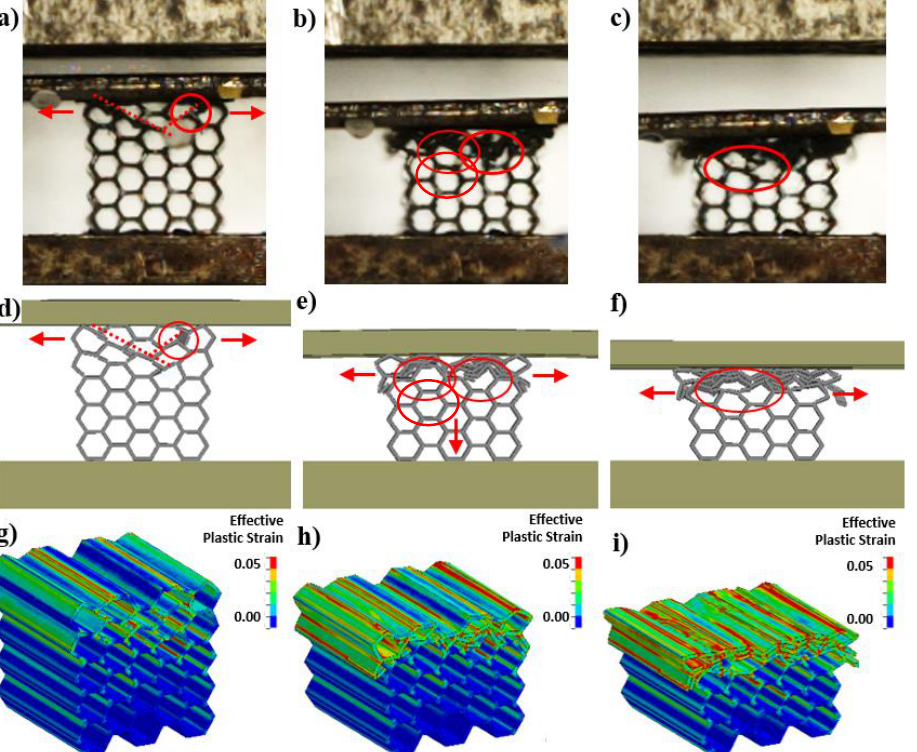
Fig. 5 . The comparison of the blast experiment of the Honeycomb structure (a,b,c) with its numerical simulation: front view (d,e,f) and the isometric view presented in maps of the effective plastic strain